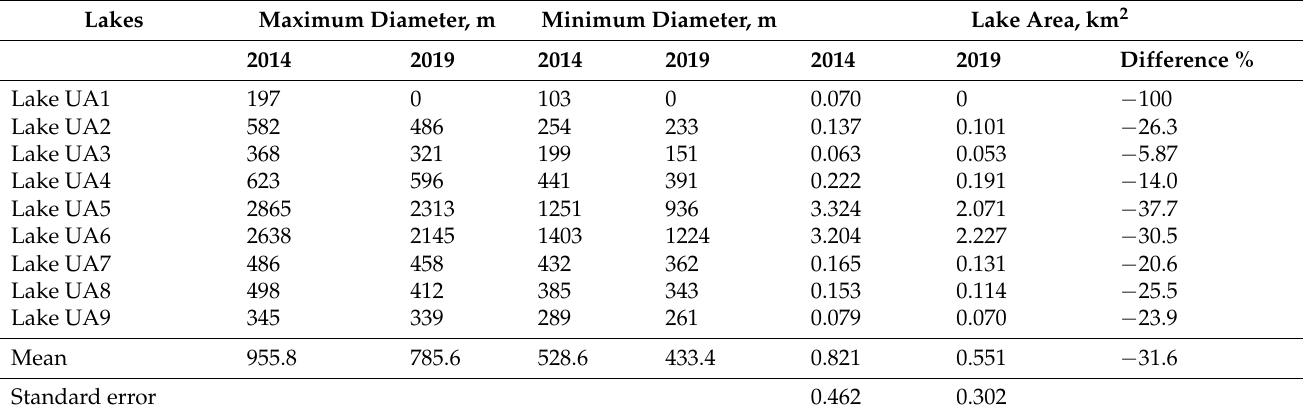
Table 1. Dynamics of the undisturbed lakes above the road. Note: areas are estimated in a standard- ized way and are not absolute.